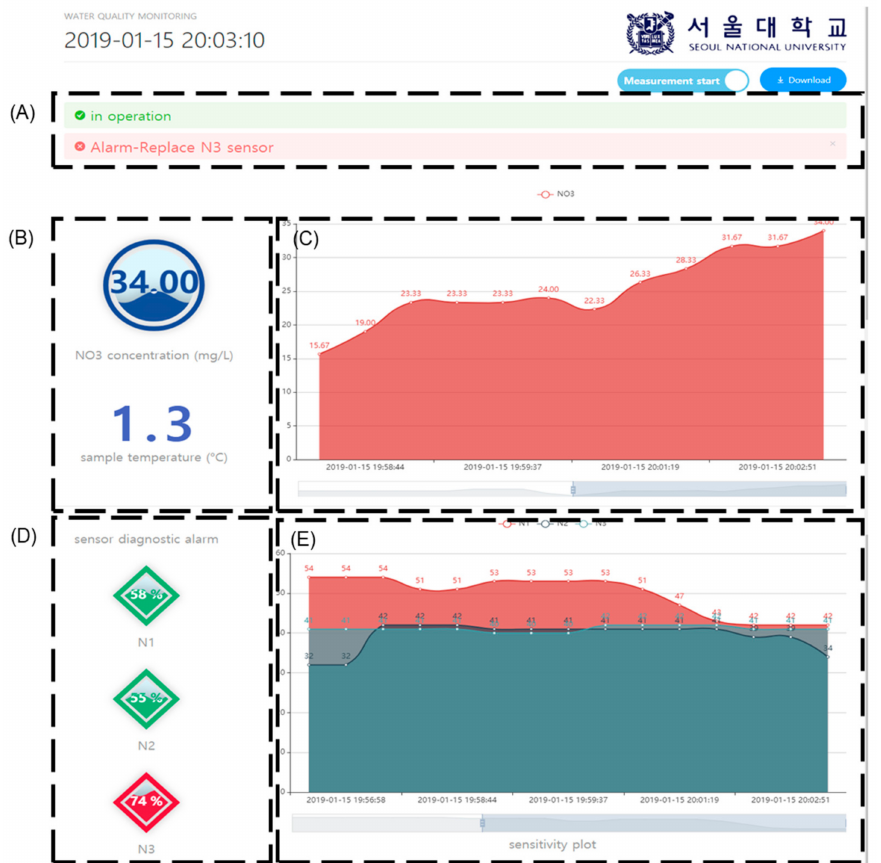
Figure 8. Cloud-based water quality monitoring webpage developed in this study: ( A ) operative status of system (green) and electrode replacement alarm (red); ( B ) current nitrate concentration and representative temperature of water resource; ( C ) plot of nitrate concentration and point data; ( D ) self-diagnostic indices (SDIs) of electrodes and ( E ) previous sensitivity